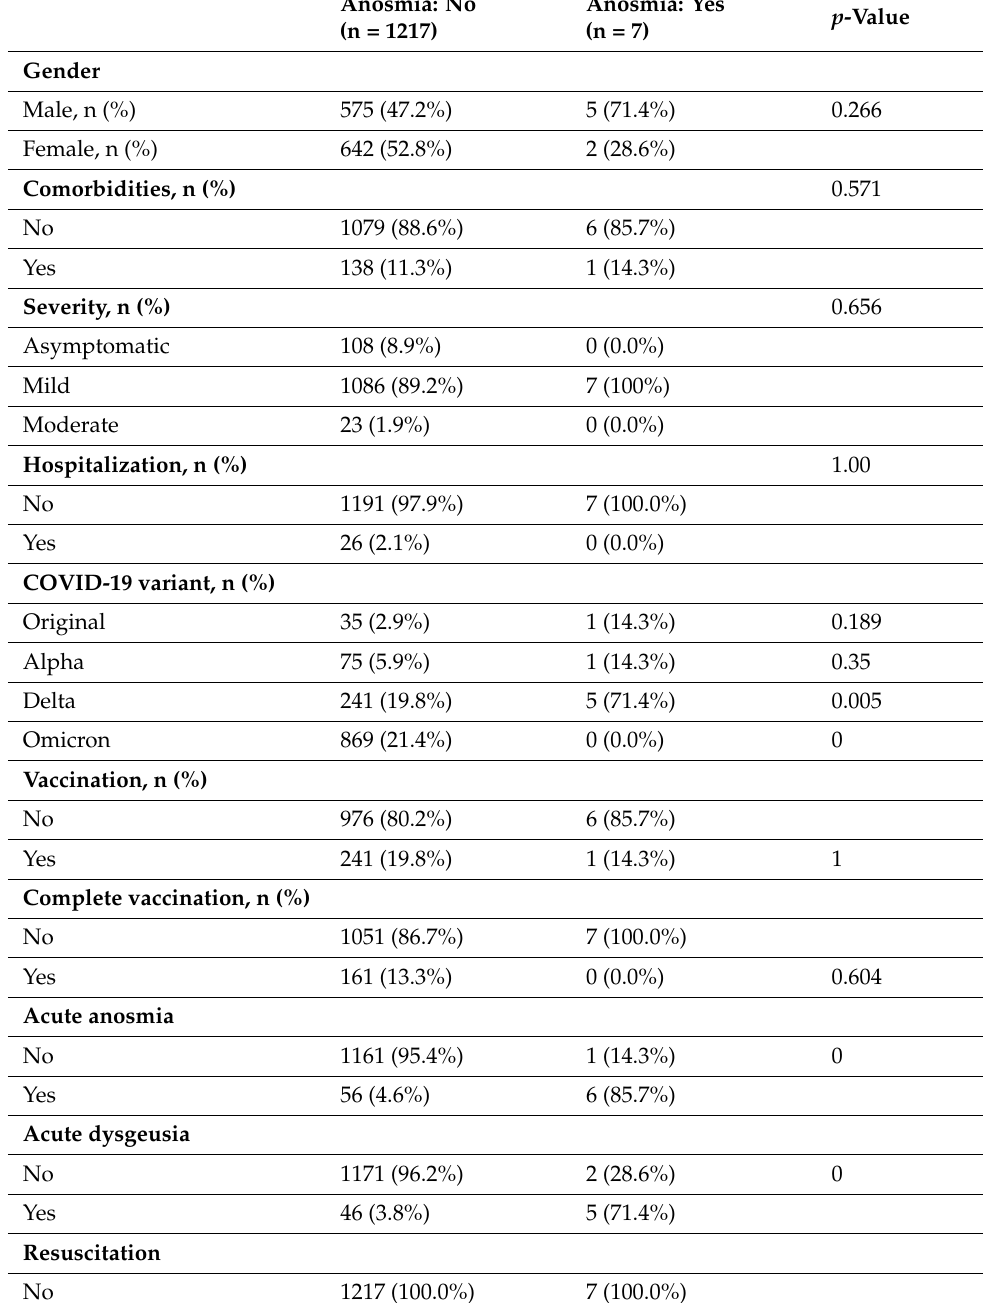
Table 5. Anosmia at FUP